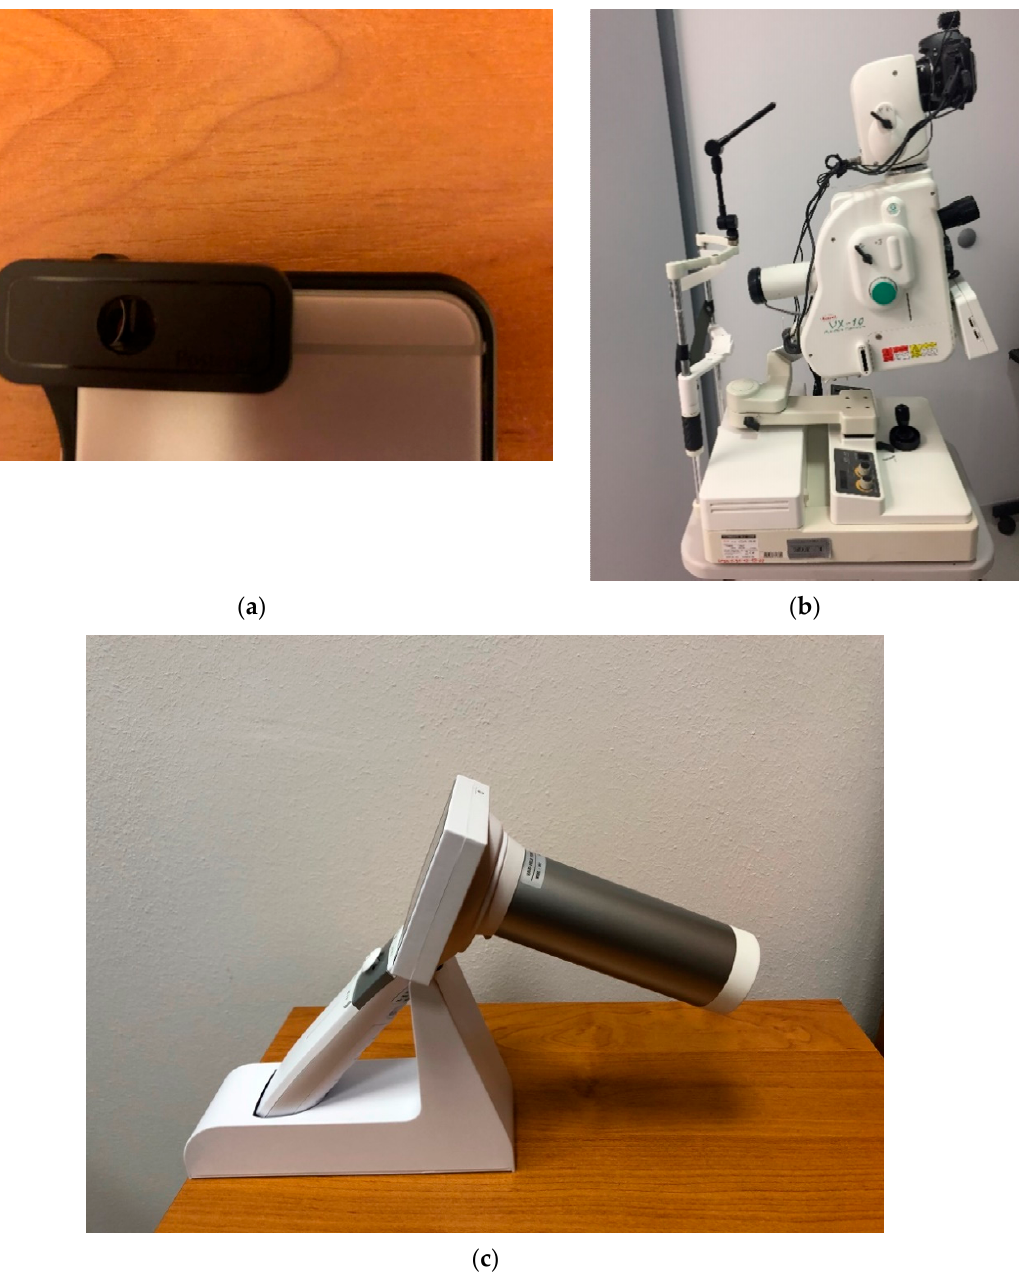
Figure 2. All devices used during research: ( a ) d-Eye overlay for smartphone, ( b ) Kowa VX-10 Fundus Camera, and ( c ) Digital Eye Center Microclear Handheld Ophthalmic Camera HNF. Table 1. Comparison of all device parameters.